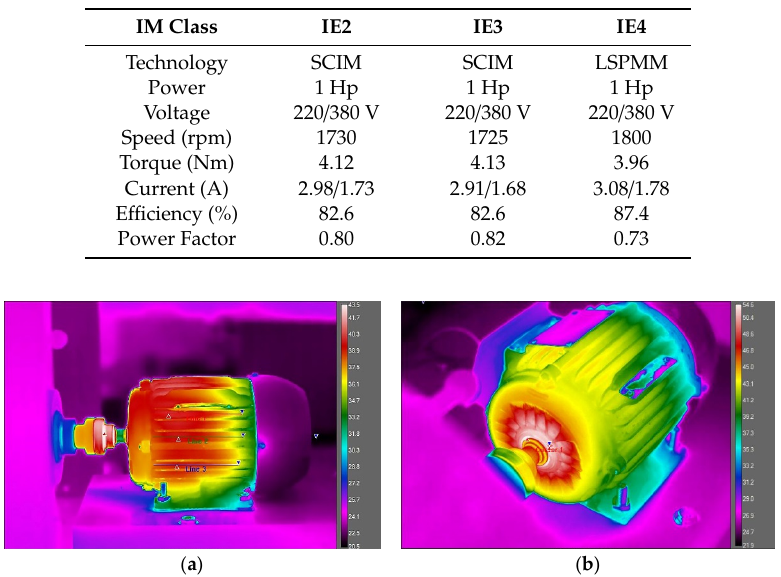
Figure 5. ( a ) Thermographic image of LSPMM with 25% of 5th harmonic voltage distortion; ( b ) thermographic image of LSPMM with 10% of 5th harmonic voltage distortion.